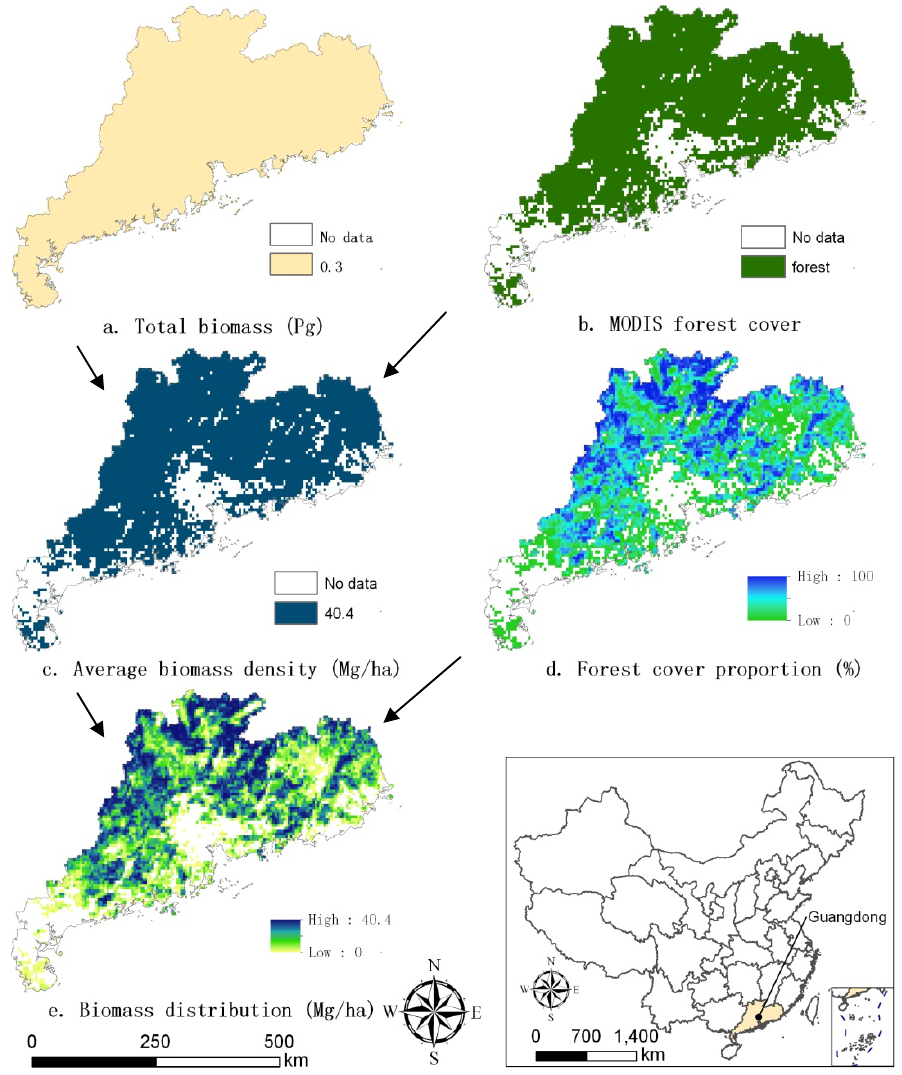
Figure 5. Schematic diagram for downscaling forest biomass (Guangdong province). ( a ) Total forest biomass obtained from the statistics (provincial level); ( b ) Forest cover derived from the MODIS product; ( c ) The average biomass density distribution (forest-cover level); ( d ) The calibrated forest cover proportion map; ( e ) The distribution of forest biomass (sub-pixel